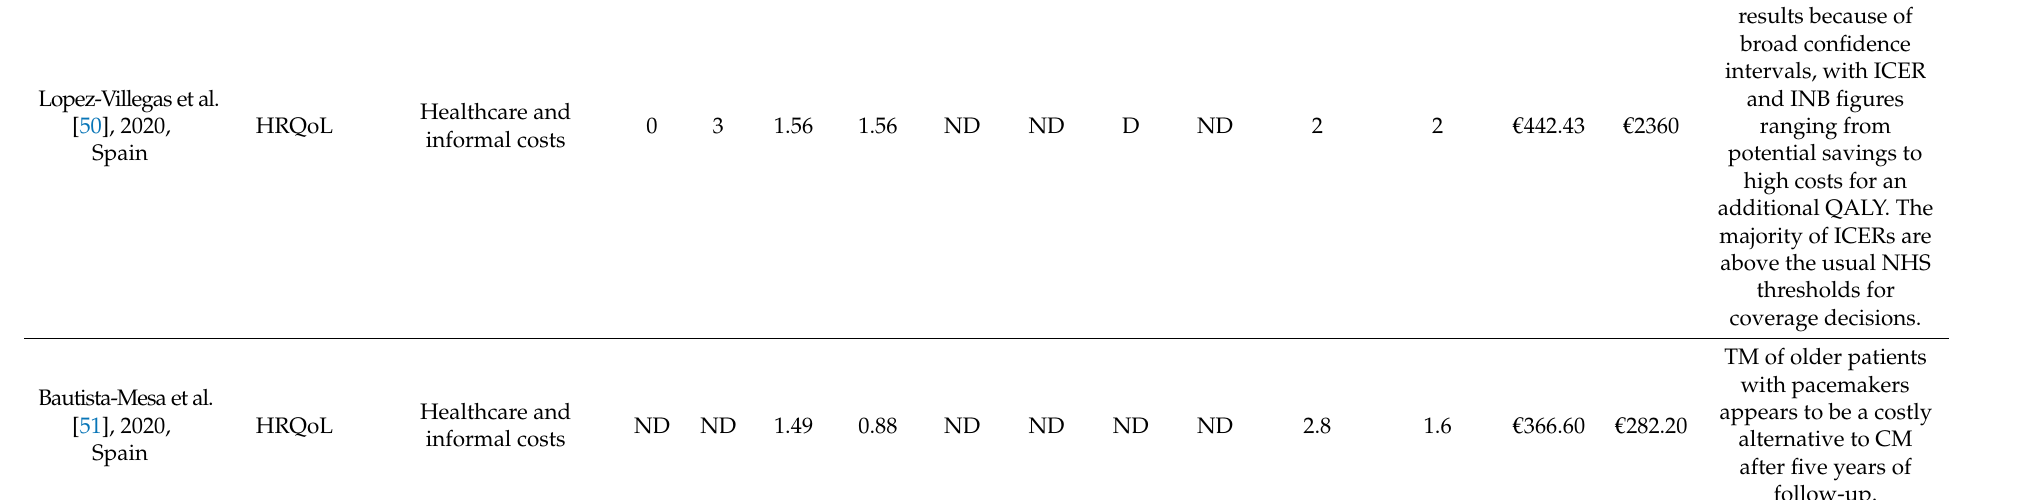
additional QALY. The